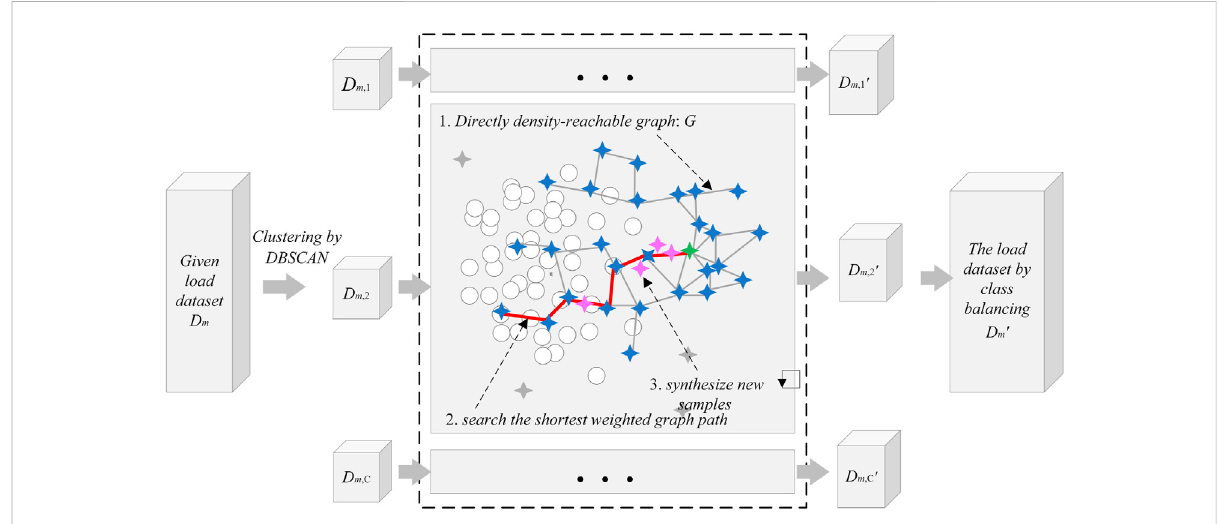
FIGURE 1 The entire process of GSDC in enabling class balance of the load